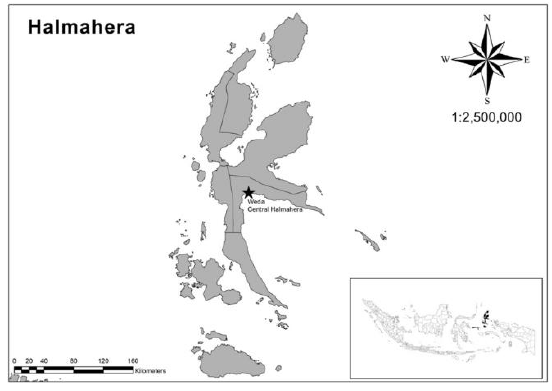
Figure 1. Research sampling location at Weda, Central Halmahera District, North